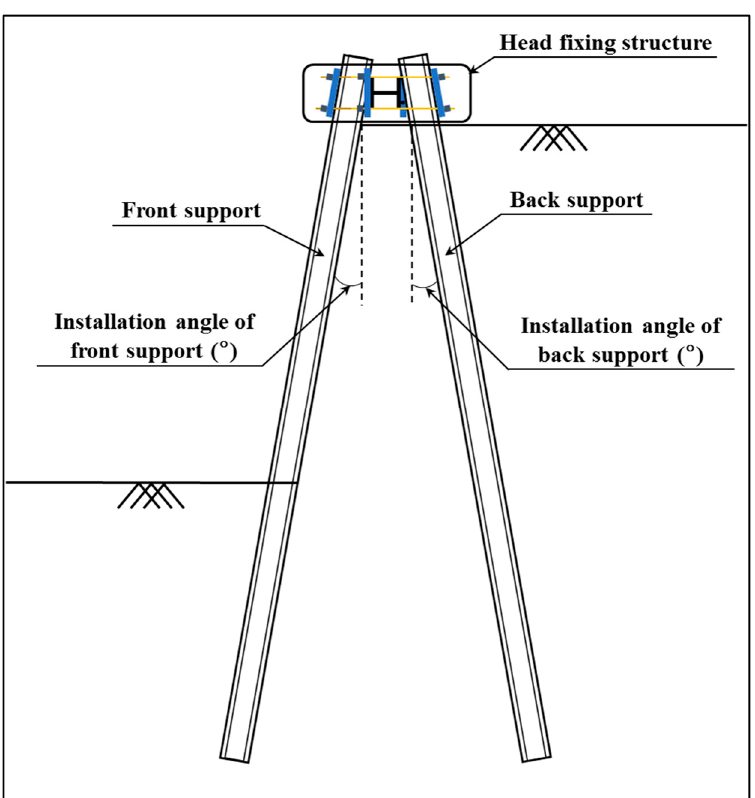
Figure 1. Basic structure of the IER (inclined earth retaining) method.